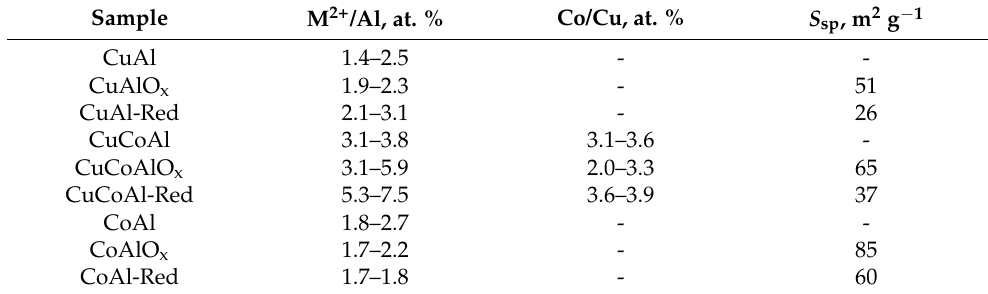
Table 2. M 2+ /Al and Co/Cu ratios calculated from energy dispersive analysis, as well as specific surface area of calcined (550 ◦ C) and reduced (800 ◦ C)